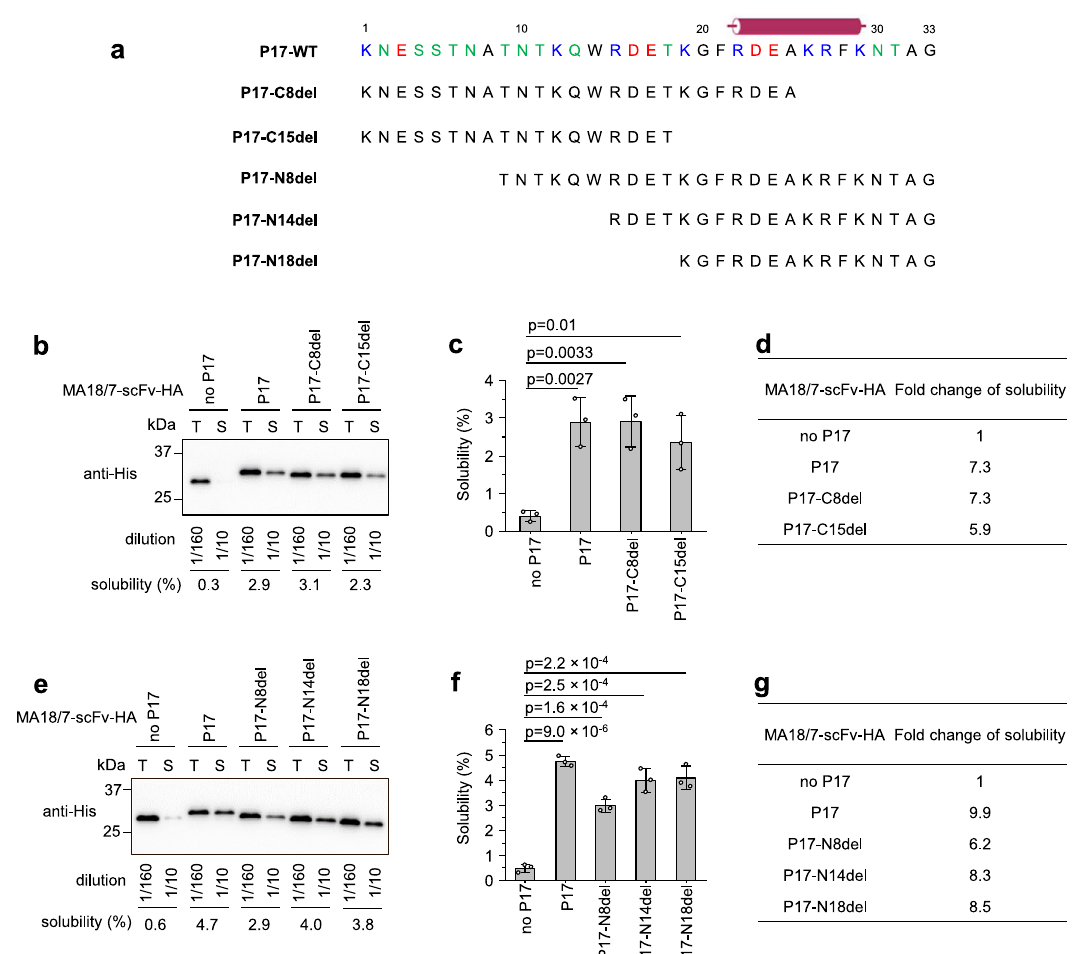
Fig.6|BothNandC-terminalsequencesoftheP17tagcontributetoenhanced scFv solubilityin SHuf fl e T7 cells. a Amino acidsequencesofwtP17tag(P17-WT) anditstruncatedmutantswithvariousdeletionsofC-orN-terminalresidues.Basic, acidic, and polar residues are shown in blue, red, and green, respectively. The putative α -helix from P17 residues 22 – 29 is denoted with a cylinder.